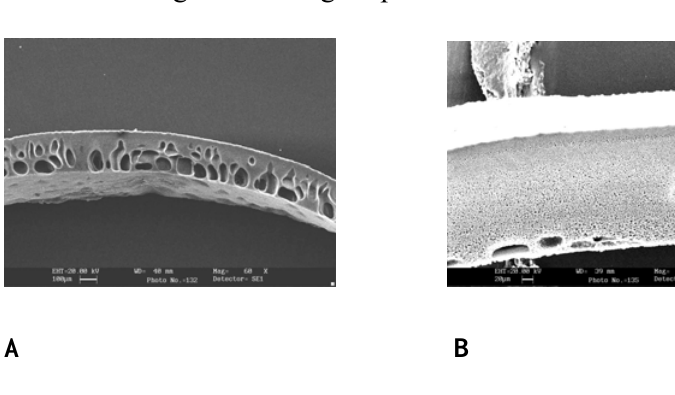
Figure 1. Scanning electron micrograph of the asymmetric membrane wall (A) cross section, at 60× magnification (B) porous region showing pores at 200× magnification (c) dense region showing no